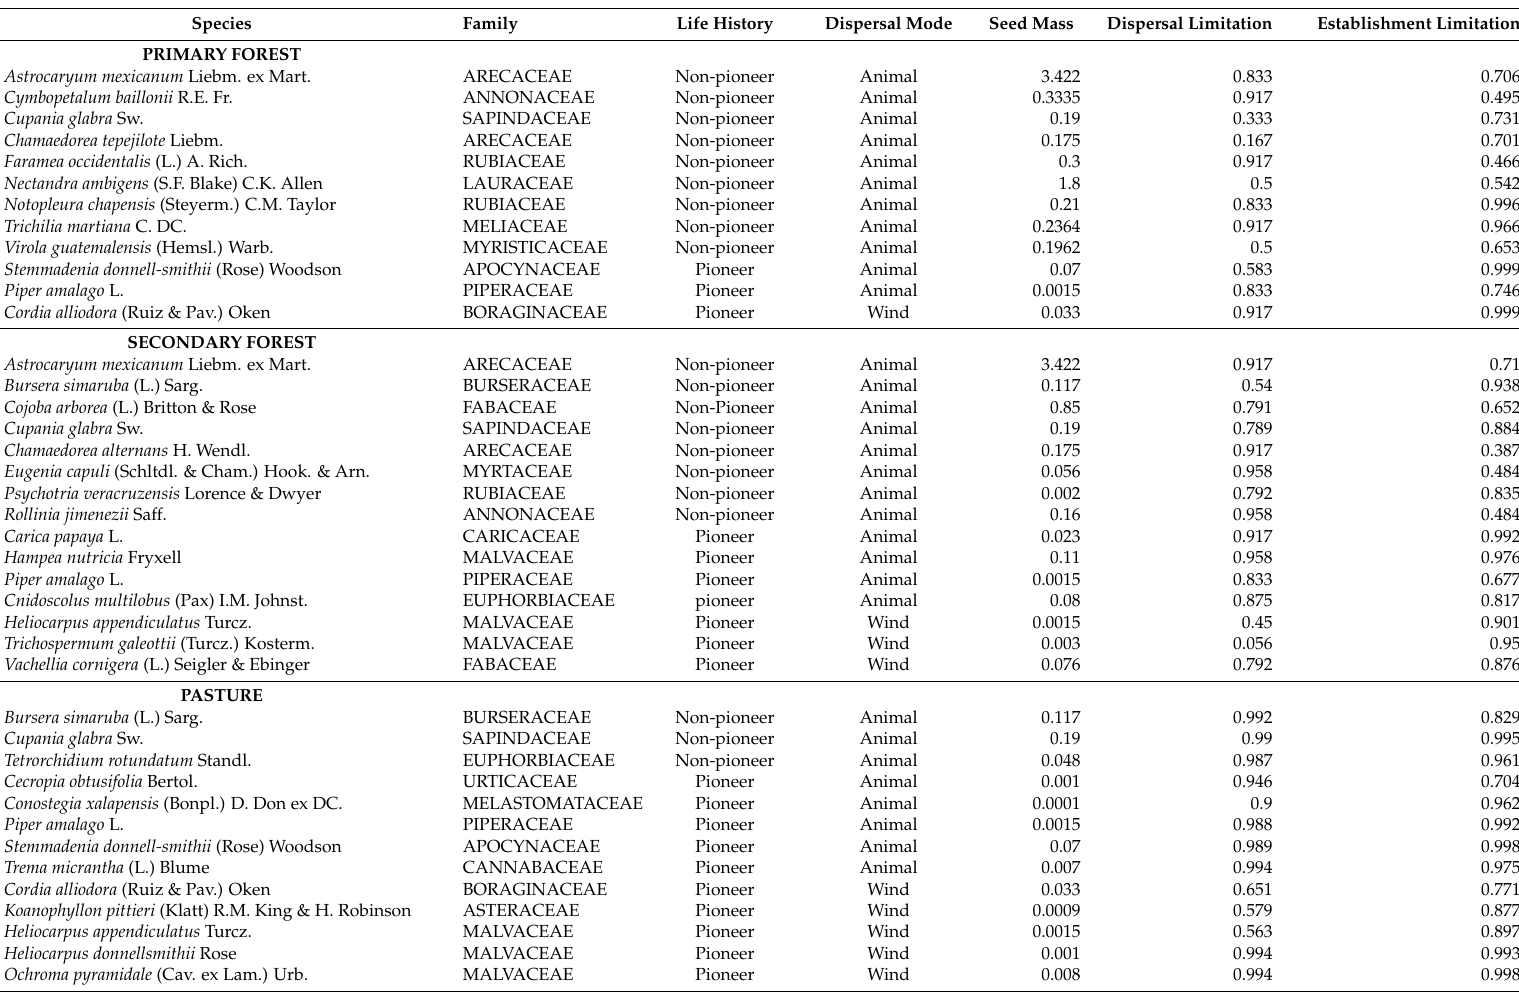
Table 2. Families, life history, dispersal mode, seed mass (g) and, dispersal and establishment limitation, of species registered in the seed rain and recruited in primary and secondary forest and pasture in Los Tuxtlas, Veracruz categorized by